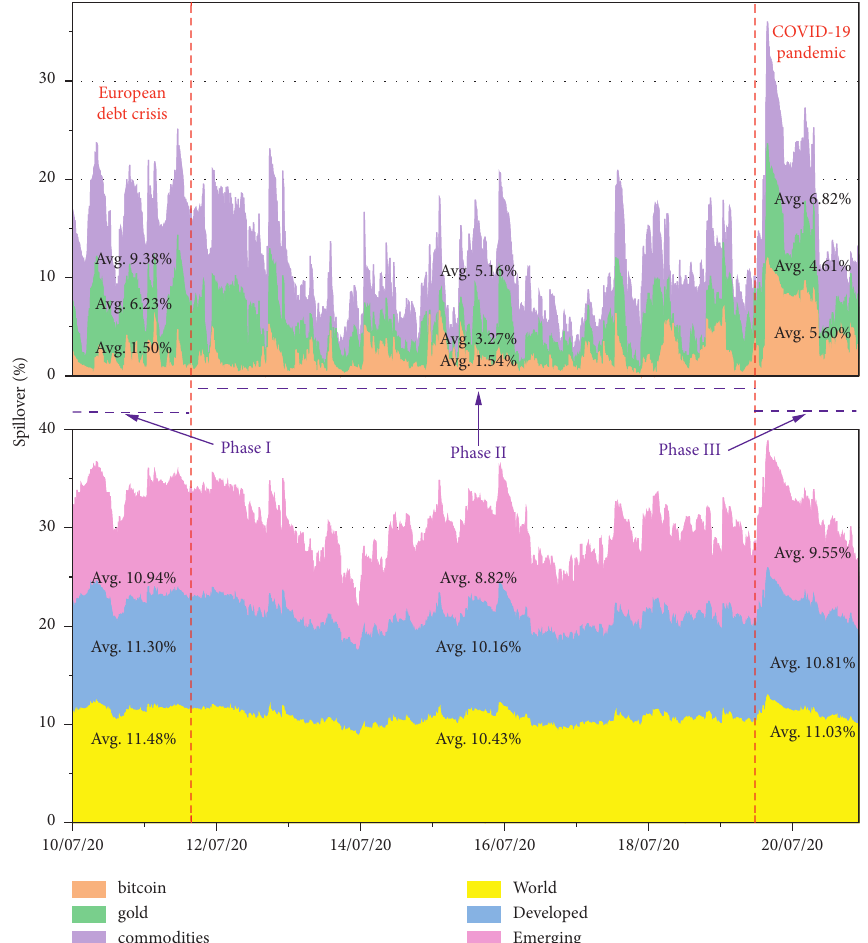
Figure 4: Total directional spillover from others for TVP-VAR. The different color areas define the accumulation of total directional spillover from other markets. The total directional spillover from others of returns plotted here is computed by equation (11), which is defined as the difference in total directional connectedness from others. All abbreviations are as follows: bitcoin, gold, and commodities indices (commodities); the world stock index (world); the developed stock index (developed); and the emerging stock index (emerging). The sample period for returns is from July 20, 2020, to June 23,